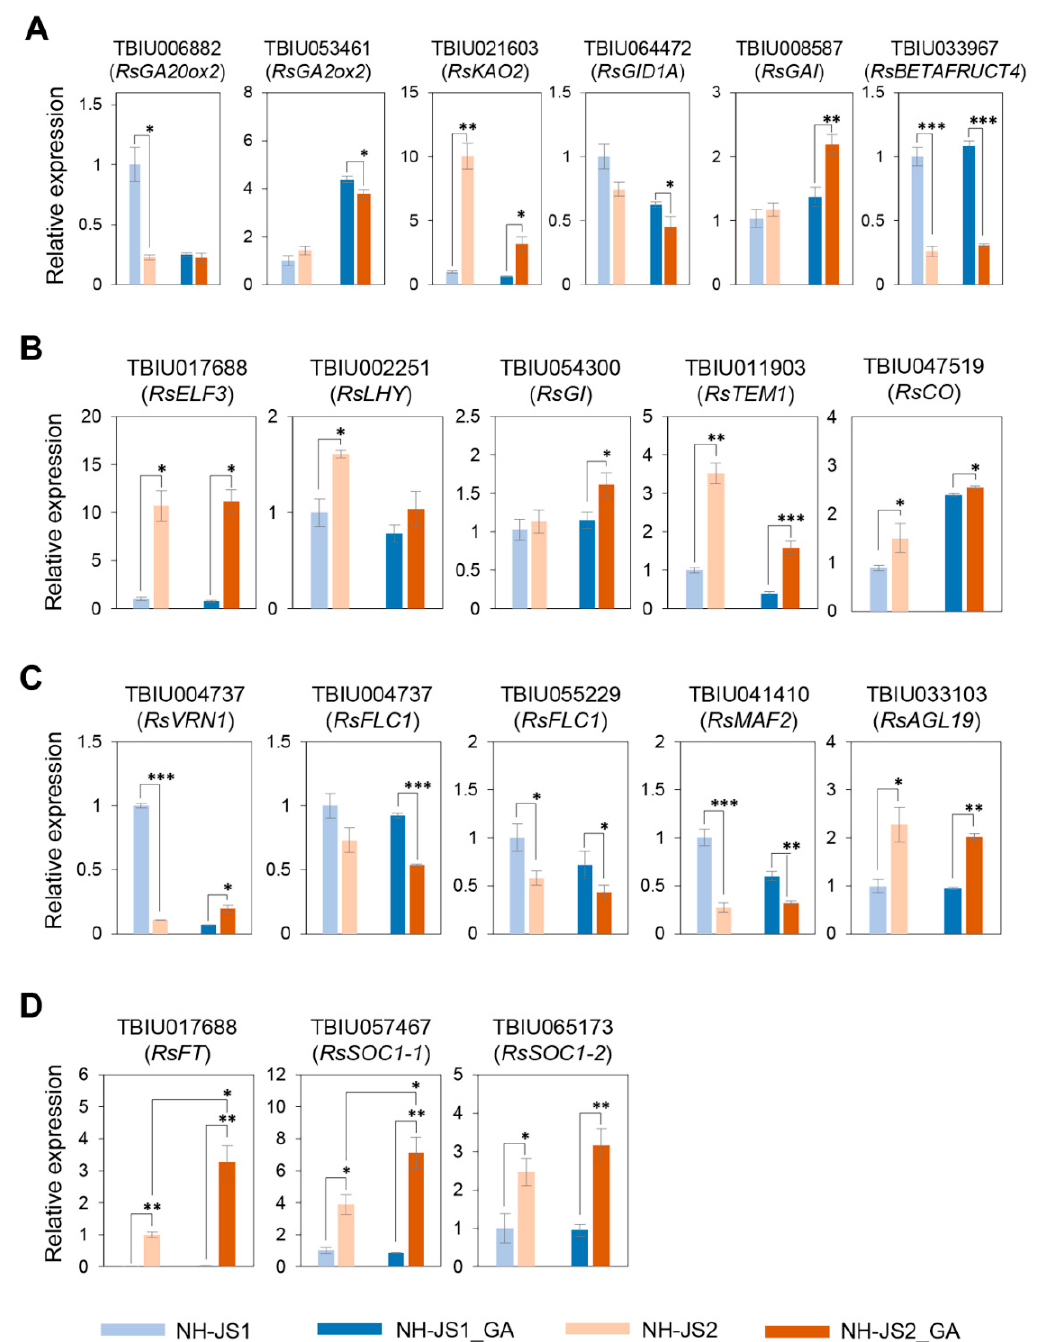
Figure 5. Quantitative PCR analysis of flowering time DEGs in the two inbred radish lines in response to gibberellin. Total RNA was isolated from shoots of NH-JS1 and NH-JS2 inbred lines 6 days after treatment with or without GA (0 or 10 mM) spray application. The complementary DNA was synthesized from total RNA. Upregulated and downregulated genes are grouped according to biological pathways determined from gene ontology analysis. Flowering time genes involved in GA pathway ( A ), photoperiod pathway ( B ), vernalization pathway ( C ) and flowering integrators ( D ). The qPCR values were normalized relative to RsACT1 (actin) expression level. Error bars represent ± standard error of biological triplicates. Asterisks indicate statistically significant di ff erences (NH-JS2 vs. NH-JS1 and NH-JS2_GA vs. NH-JS1_GA; Student’s t test; * p < 0.05, ** p < 0.01, and *** p < 0.005; two-tailed Student’s t